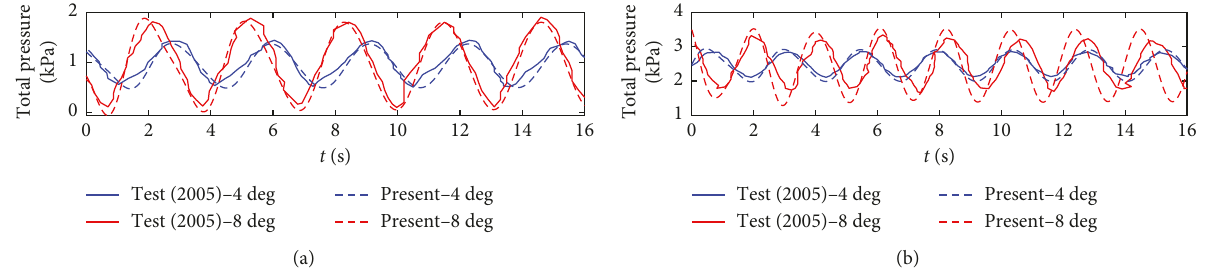
Figure 9: Comparison of pressure on tank wall: (a) h